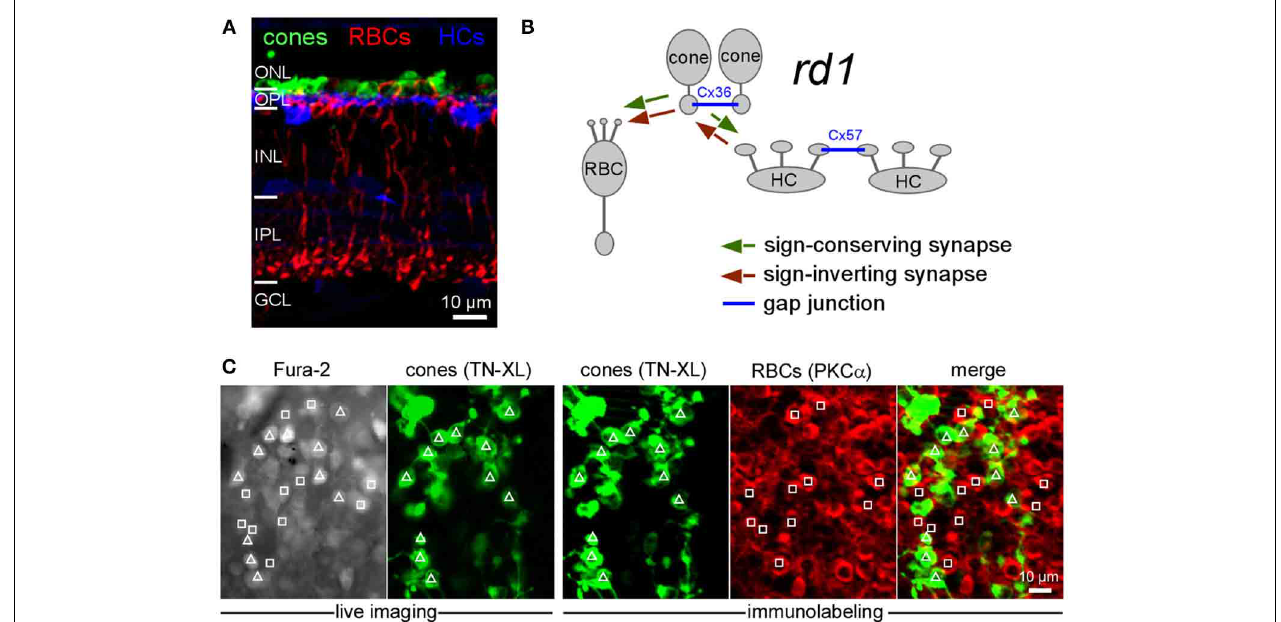
FIGURE 1 | Cell type identification following Ca 2 + imaging in the outer retina of rd1 mice. (A) Vertical section of a P35 rd1 retina immunostained for TN-XL (cones), PKC α (RBCs) and calbindin (HCs). (B) Drawing illustrating sign-conserving (green), sign-inverting (red), and electrical (blue) synaptic interactions in the outer rd1 retina. For simplicity, interactions between HCs and RBCs are not shown. (C) From left to right: Fura-2-labeled neurons in outer retina in living P35 rd1 wholemount retina